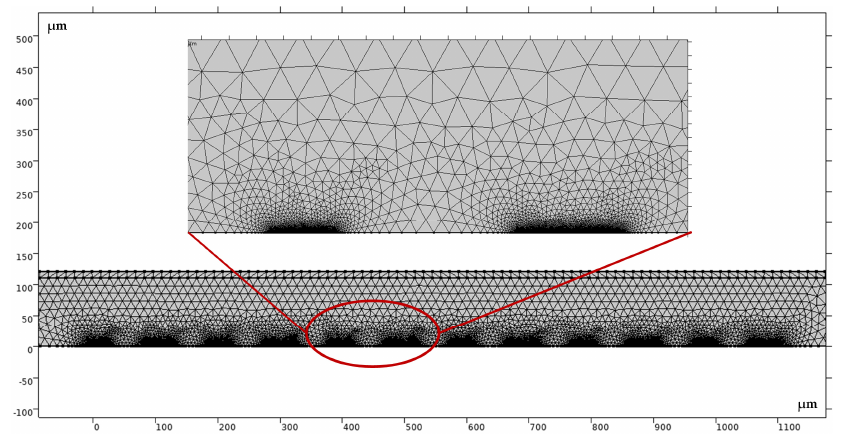
Figure 2. Finite element mesh generation diagram.